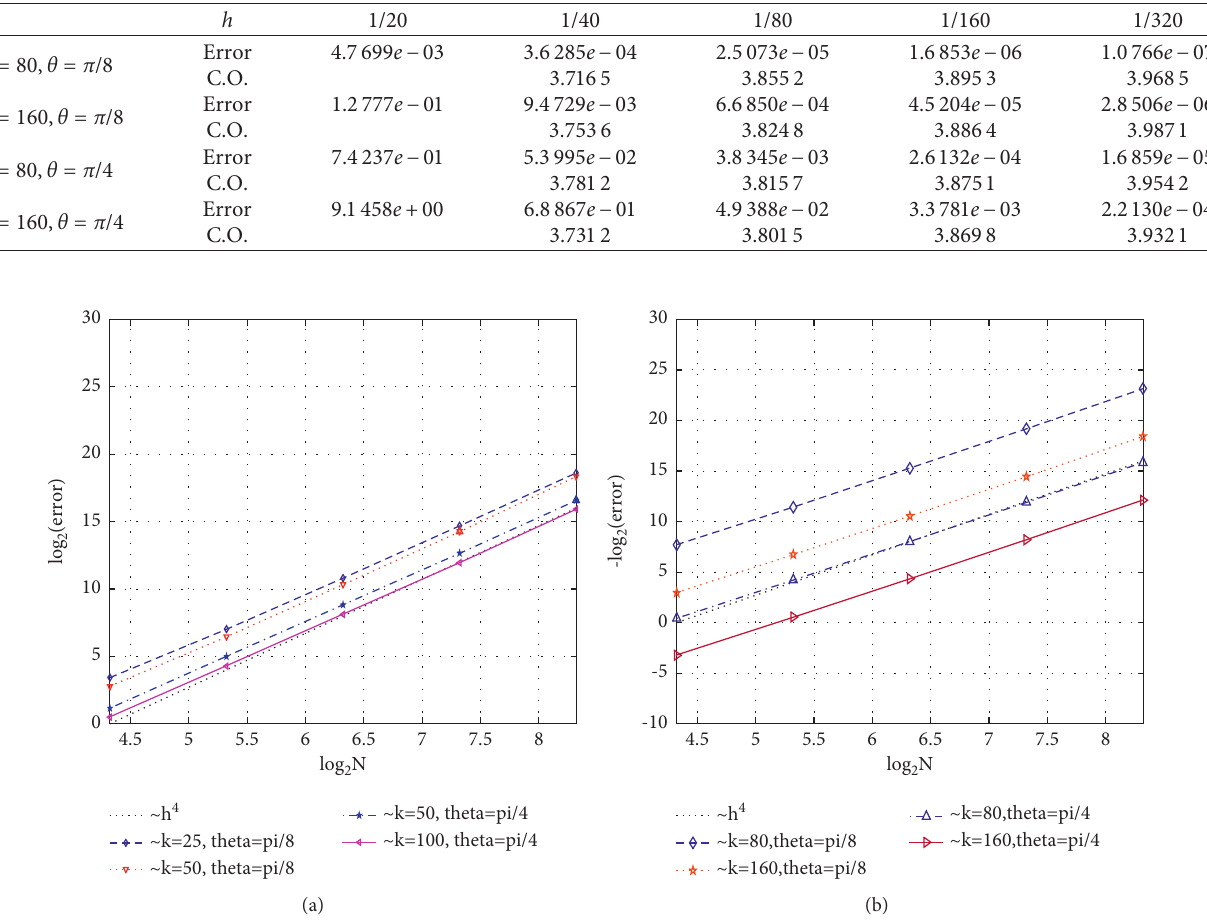
Table 4: Numerical convergence and error of the new 21-point difference scheme for Example 3.